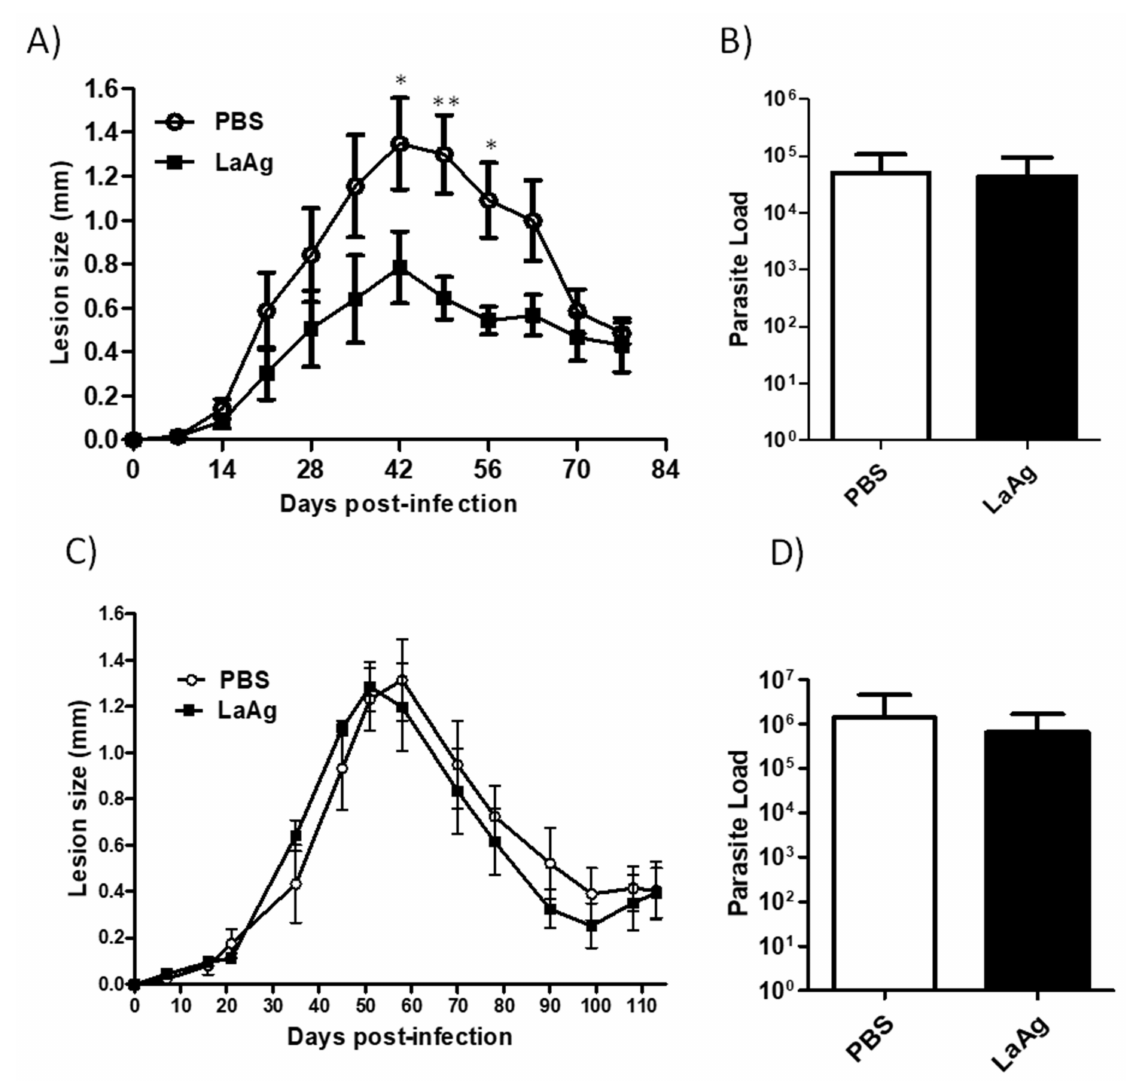
Figure 1. C57BL/6 mice immunized with the intramuscular LaAg vaccine showed partial reduction in the lesion size when infected with 2 × 10 5 promastigotes. Mice were injected with the LaAg vaccine or phosphate buffered saline (PBS) and then infected with 2 × 10 5 ( A , B ) and 2 × 10 6 ( C , D ) L. amazonensis stationary phase promastigotes in the right hind footpad. The lesion development was monitored using a caliper on the indicated days until the 77th ( A ) day post-infection and 113th ( C ) day post-infection. ( B , D ) The footpads were removed at the end of the respective periods, macerated and used in an limiting dilution assay (LDA) to determine the parasite load. Data are representative of two independent experiments (mean ± standard deviation; n = 5). ** p < 0.01, * p < 0.05; assessed by two-way analysis of variance (ANOVA) using Bonferroni’s